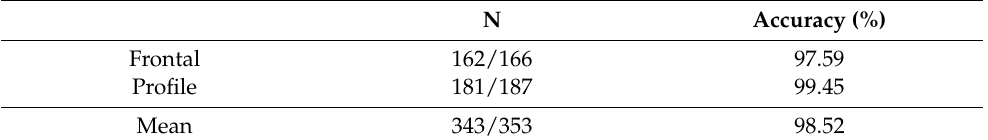
Table 2. Comparison of the accuracy of the frontal and profile views for normalizing equine facial posture. N